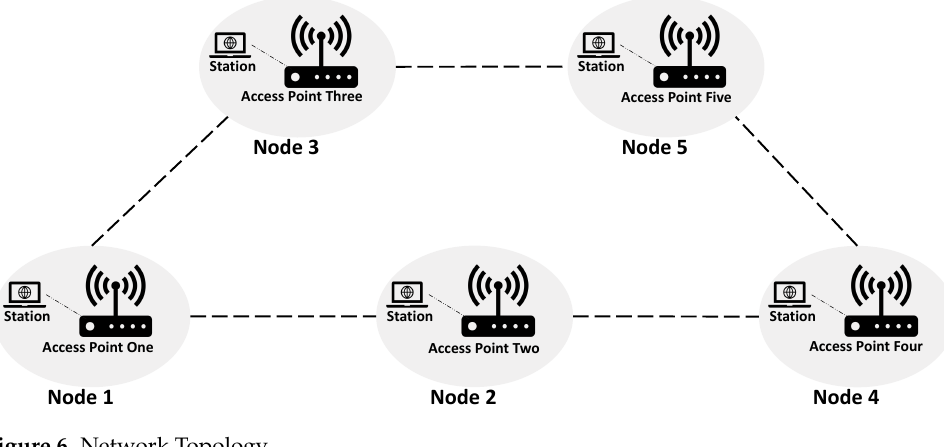
Figure 6. Network